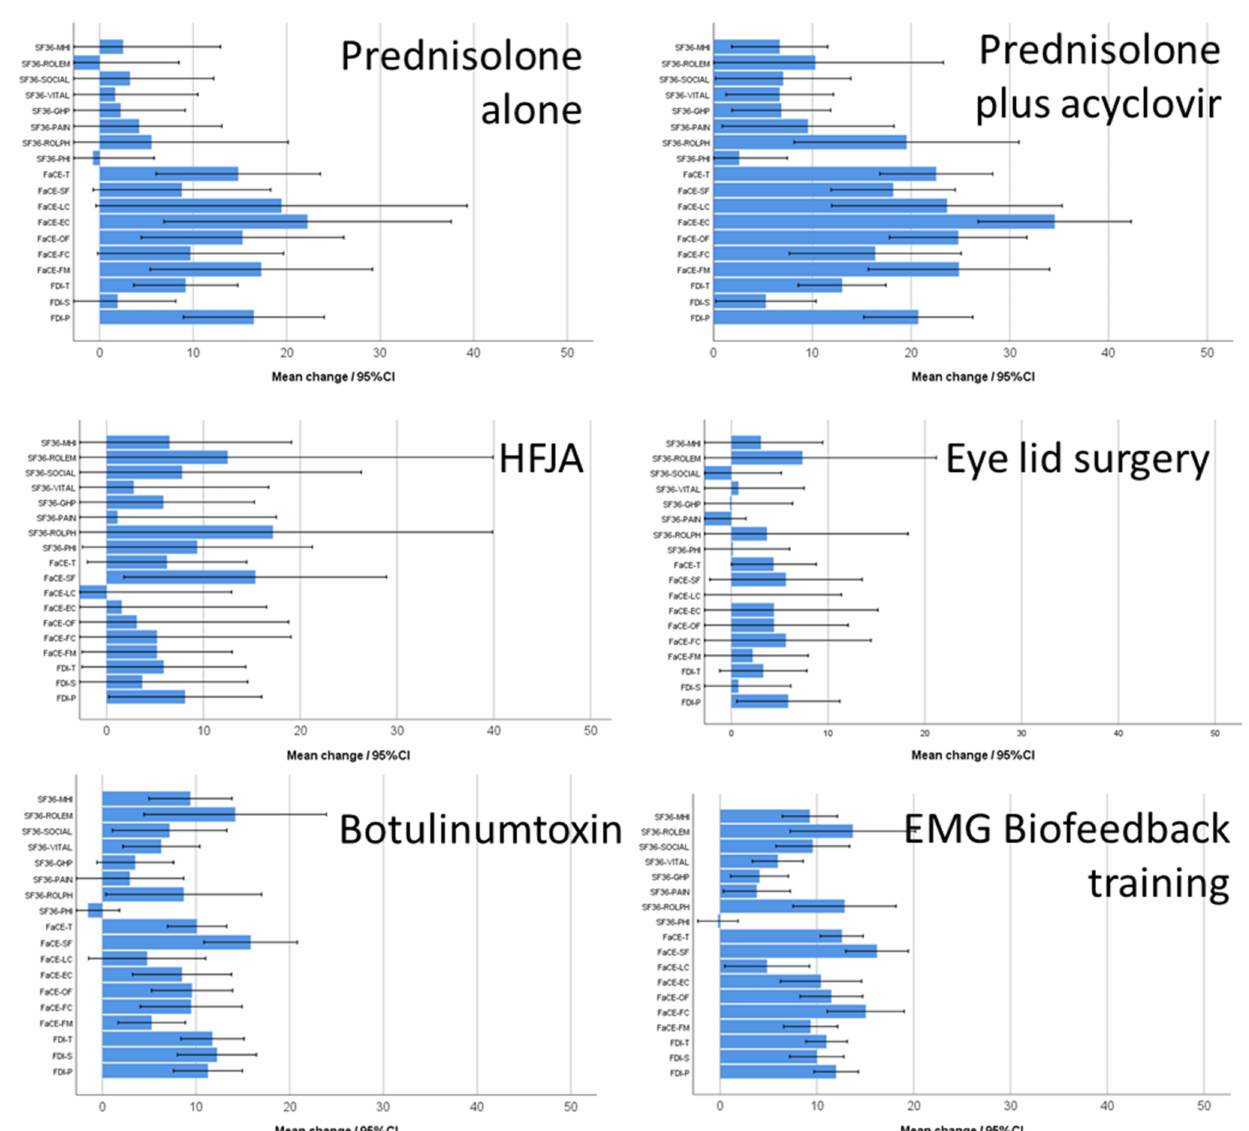
Figure 2. Absolute improvement of facial function between initial and last evaluation in the Facial Nerve Center, assessed with the Facial Disability Index (FDI), the Facial Clinimetric Evaluation Scale (FaCE), and 36-Item Short Form Survey (SF-36) separately for the same subgroups as in Figure 1. FDI-P = FDI physical function, FDI-S = FDI social function; FDI-T = FDI total; FaCE-FM = FaCE facial movement; FaCE-FC = FaCE facial comfort; FaCE-OF = FaCE oral function; FaCE-EC = FaCE eye comfort; FaCE-LC = FaCE lacrimal control; FaCE-SF = FaCE social function; FaCE-T = FaCE total score; SF36-PHI = = SF-36 physical functioning; SF36-ROLPH = SF-36 physical role functioning; SF36-PAIN = SF-36 bodily pain; SF36-GHP = general health perceptions; SF36-VITAL = SF-36 vitality; SF36-SOCIAL = SF-36 social role functioning; SF36-ROLEM = SF-36 emotional role functioning; SF36-MHI = SF-36 mental health. More details on other treatment types are shown in Figure